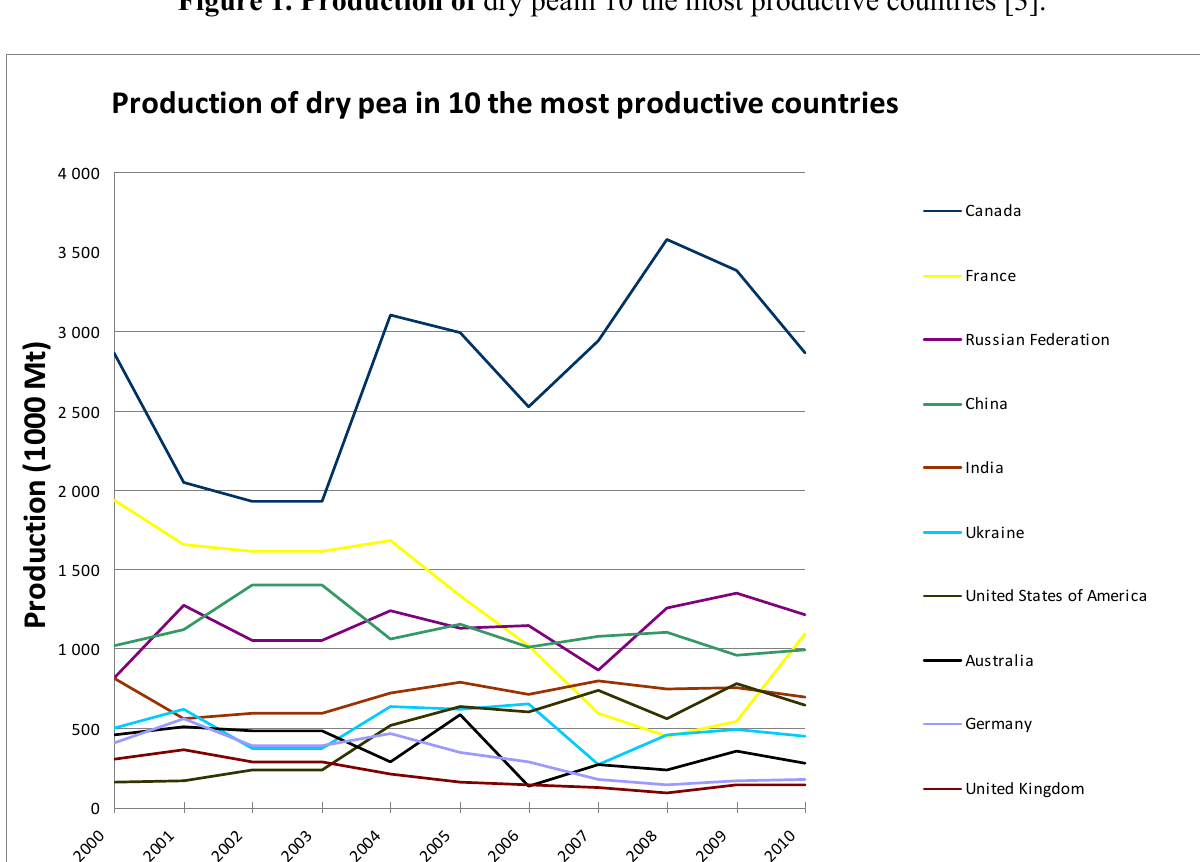
Figure 1. Production of dry peain 10 the most productive countries